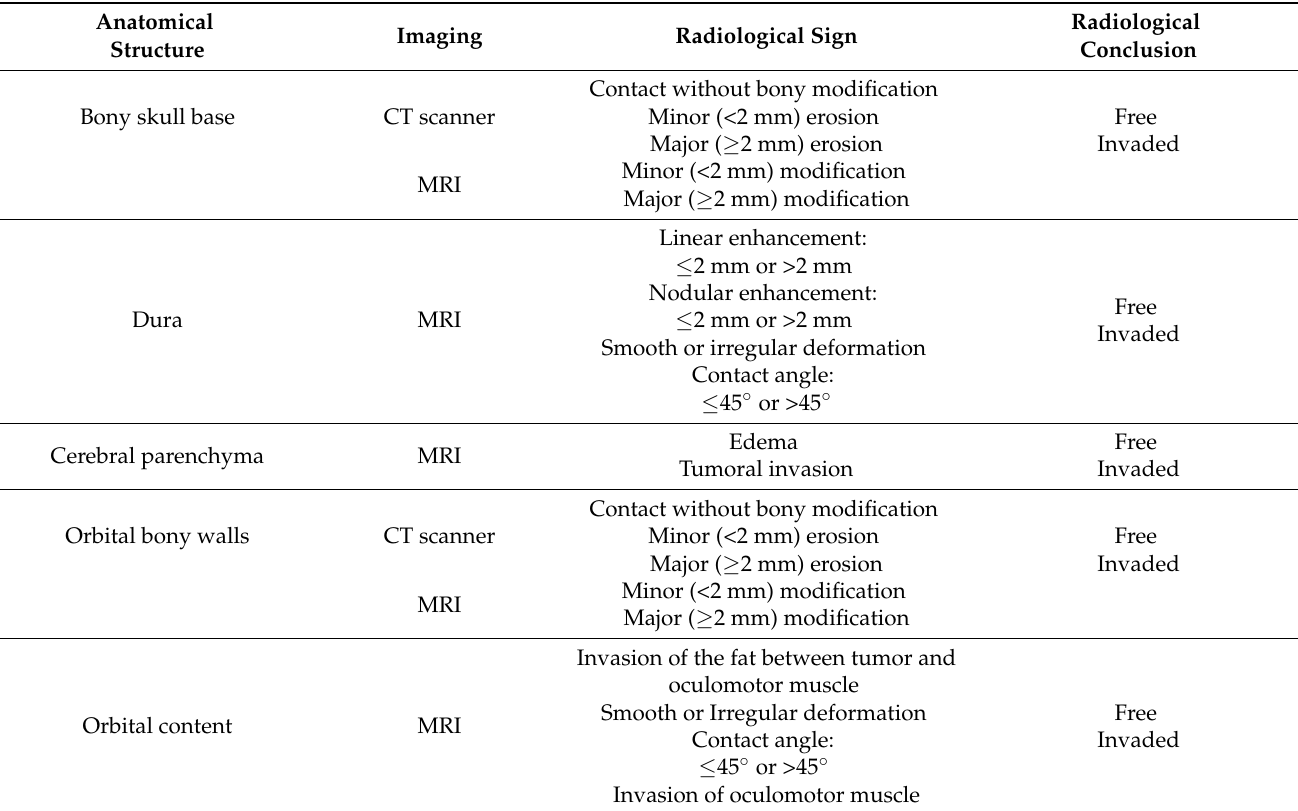
Table 1. Radiological